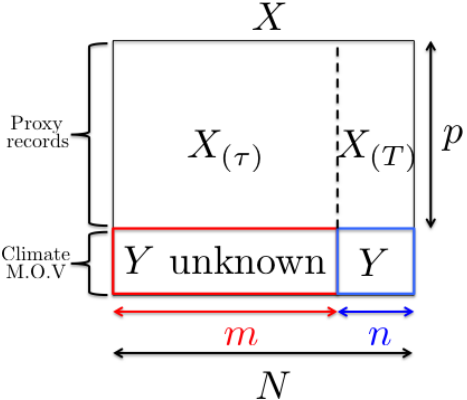
Figure 2. Scheme of the initial data. X and Y are respectively the proxy records matrix and the index of the considered mode of vari- ability. N is the size of the common period of all proxy records. n is the size of the common period of all proxy records and the index of the mode of variability. m is the size of the common period of all proxy records, where the mode of variability is not known. p is the number of proxy records. X (T) is the sub-matrix of X where the mode of variability is known. X (τ) is the sub-matrix of X where the mode of variability is not